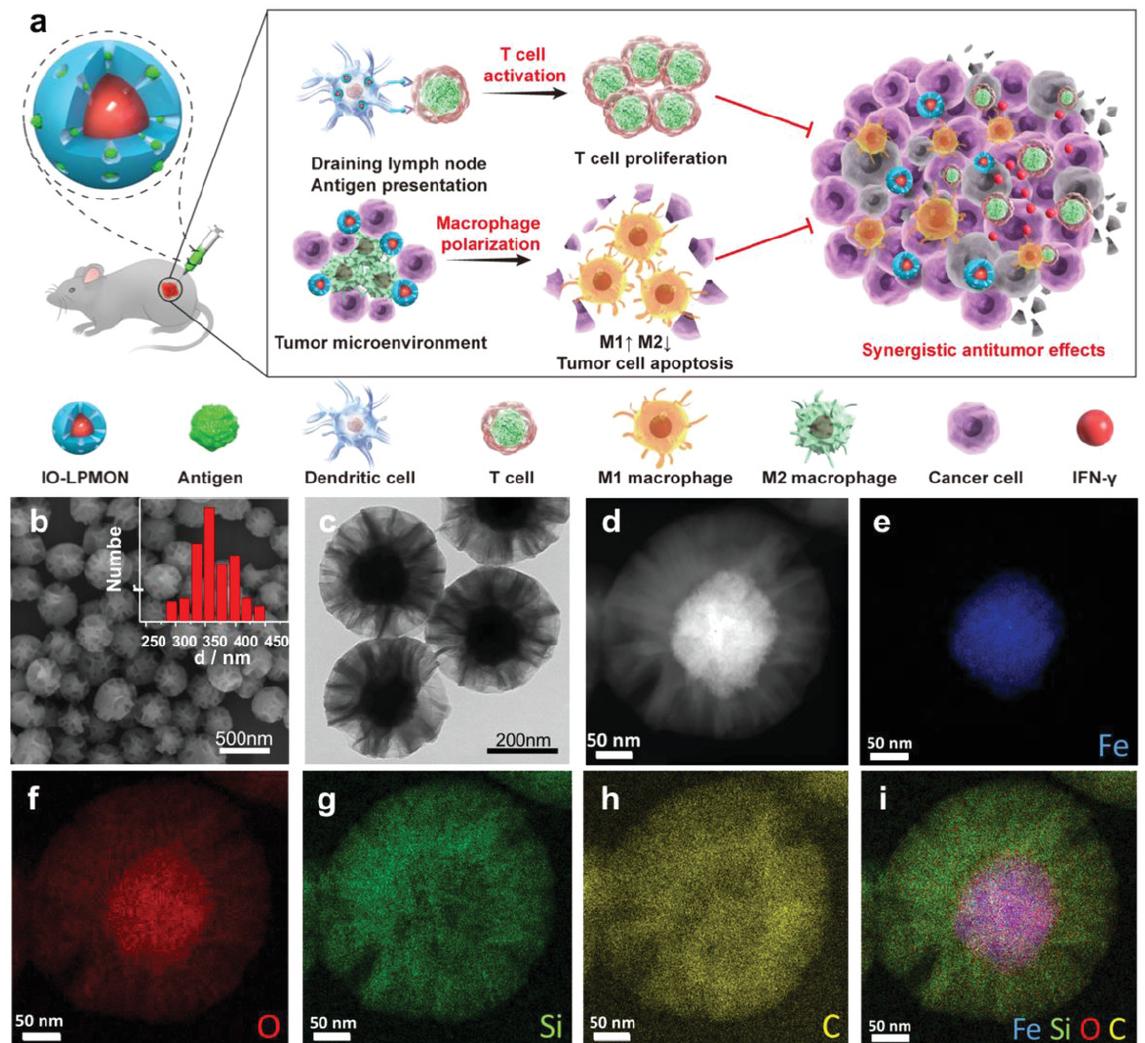
Figure 9. Schematic diagram representing MNP-mediated macrophage polarization for antitumor immunotherapy. ( a ) OVA antigen-loaded iron oxide nanoparticles modulate M2 macrophage polarization to M1 macrophages and stimulate T-cell proliferation. ( b – i ) Physiological characterization (TEM, SEM and elemental mapping of the IO-LPMON). Reproduced with permission from [106] published by John Wiley and Sons, 2021.